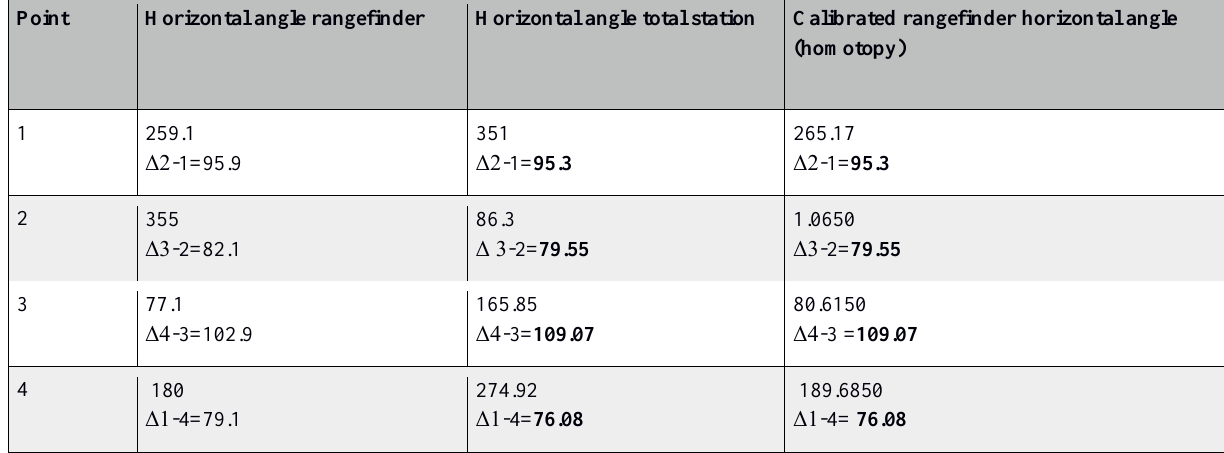
Figure 9: An artificial neural network architecture.